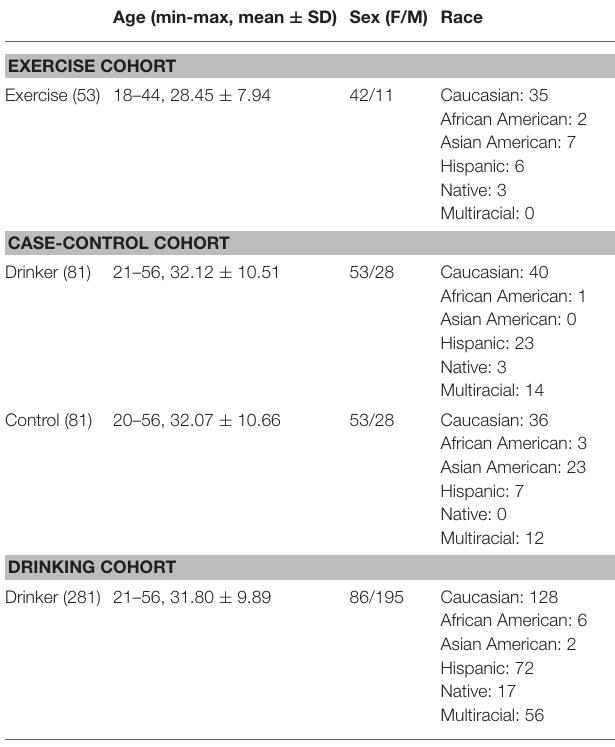
TABLE 1 | Study-wise